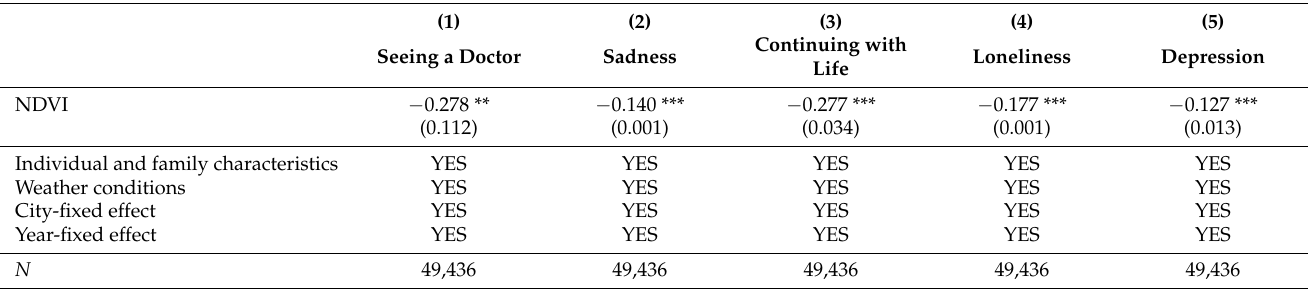
Table 6. Changing health